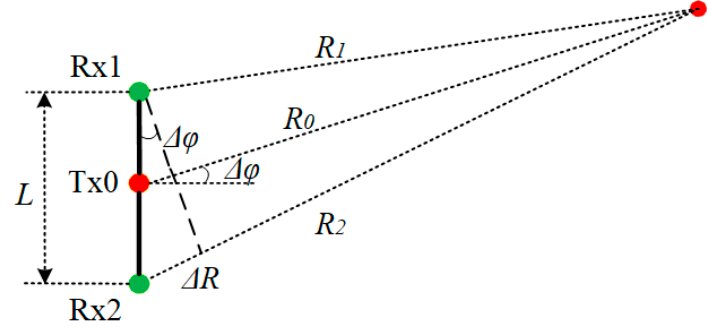
Figure 4. Illustration of angle measurement with phase difference.